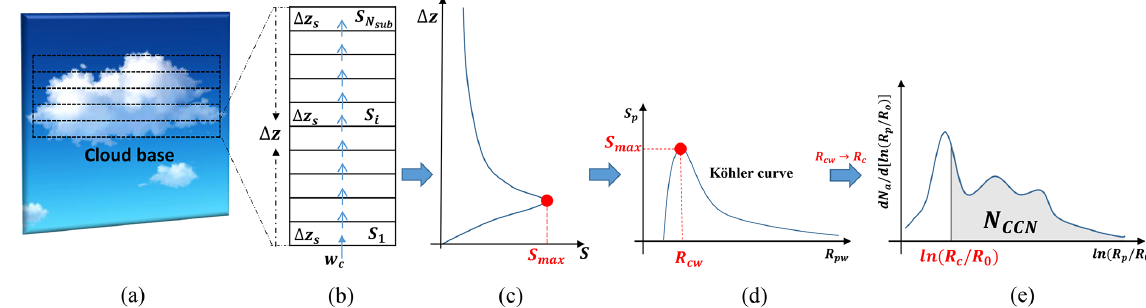
Figure 1. A schematic diagram to show the major steps of the QDGE scheme.